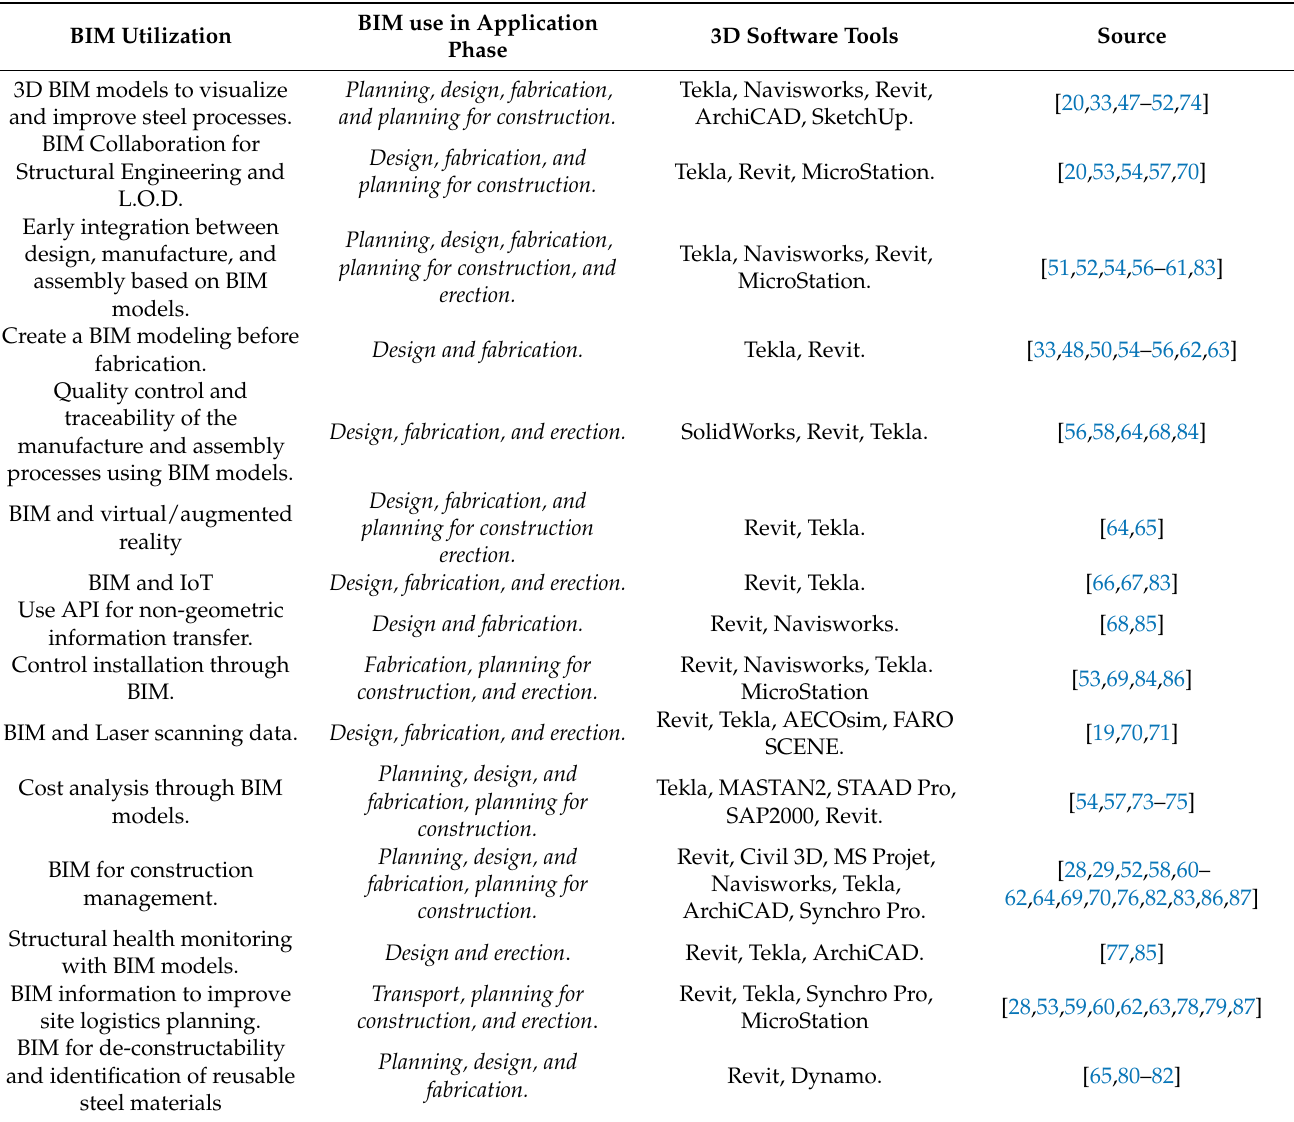
Table 6. BIM uses in application phase and bibliographic